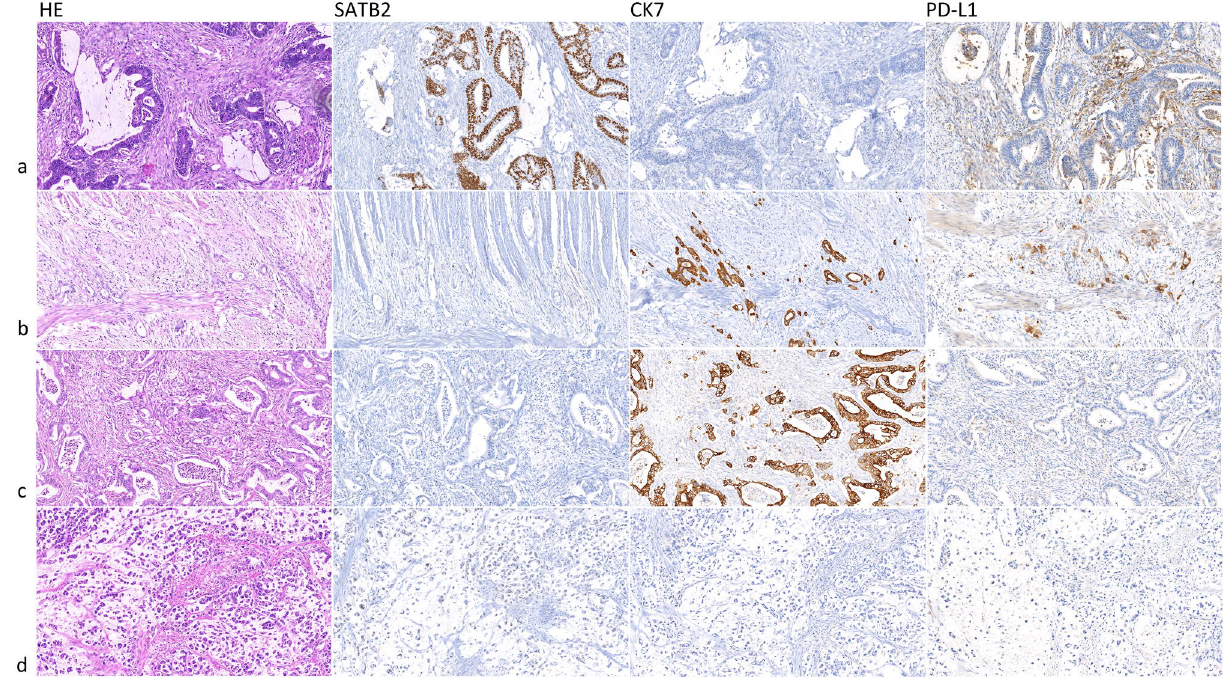
Figure 1. Histological slides showing colorectal carcinoma (CRC), hematoxylin–eosin (HE) stain, and immunohistochemistry, magnification 20×: ( a ) conventional adenocarcinoma with strong nuclear SATB2 positivity, CK7 negativity, and PD-L1 positivity in immune cells and negativity in tumor cells; ( b ) conventional adenocarcinoma with SATB2 negativity (staining in ca 1% tumor cells), strong cytoplasmic CK7 expression in 100% tumor cells, and strong membranous PD-L1 expression in ca 60% tumor cells; ( c ) conventional adenocarcinoma with SATB2 negativity, strong cytoplasmic CK7 positivity in 100% tumor cells, and PD-L1 negativity; ( d ) signet ring cell carcinoma with intracellular and extracellular mucin production showing SATB2 negativity (weak staining in ca 20% tumor cells), CK7 negativity, and PD-L1